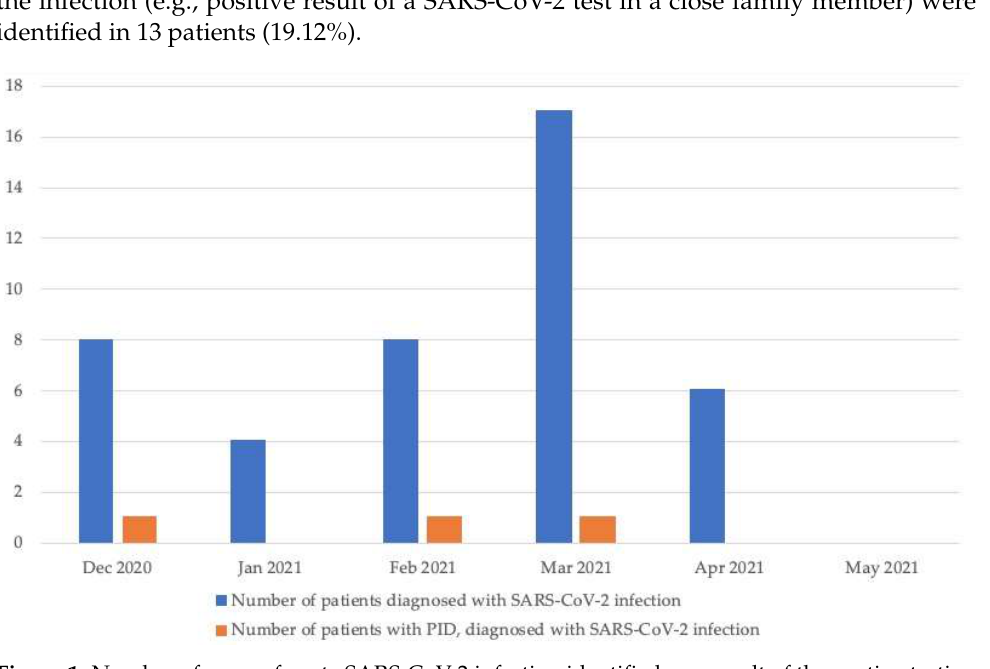
Figure 1. Number of cases of acute SARS-CoV-2 infection identified as a result of the routine testing performed before hospital admission.